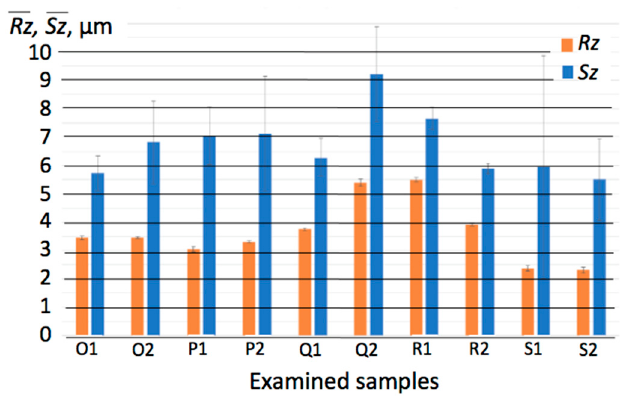
Figure 8. Average results of profile height 𝑅𝑧(cid:3364)(cid:3364)(cid:3364)(cid:3364) and respective topography height 𝑆𝑧(cid:3364)(cid:3364)(cid:3364) measurement of the samples. the